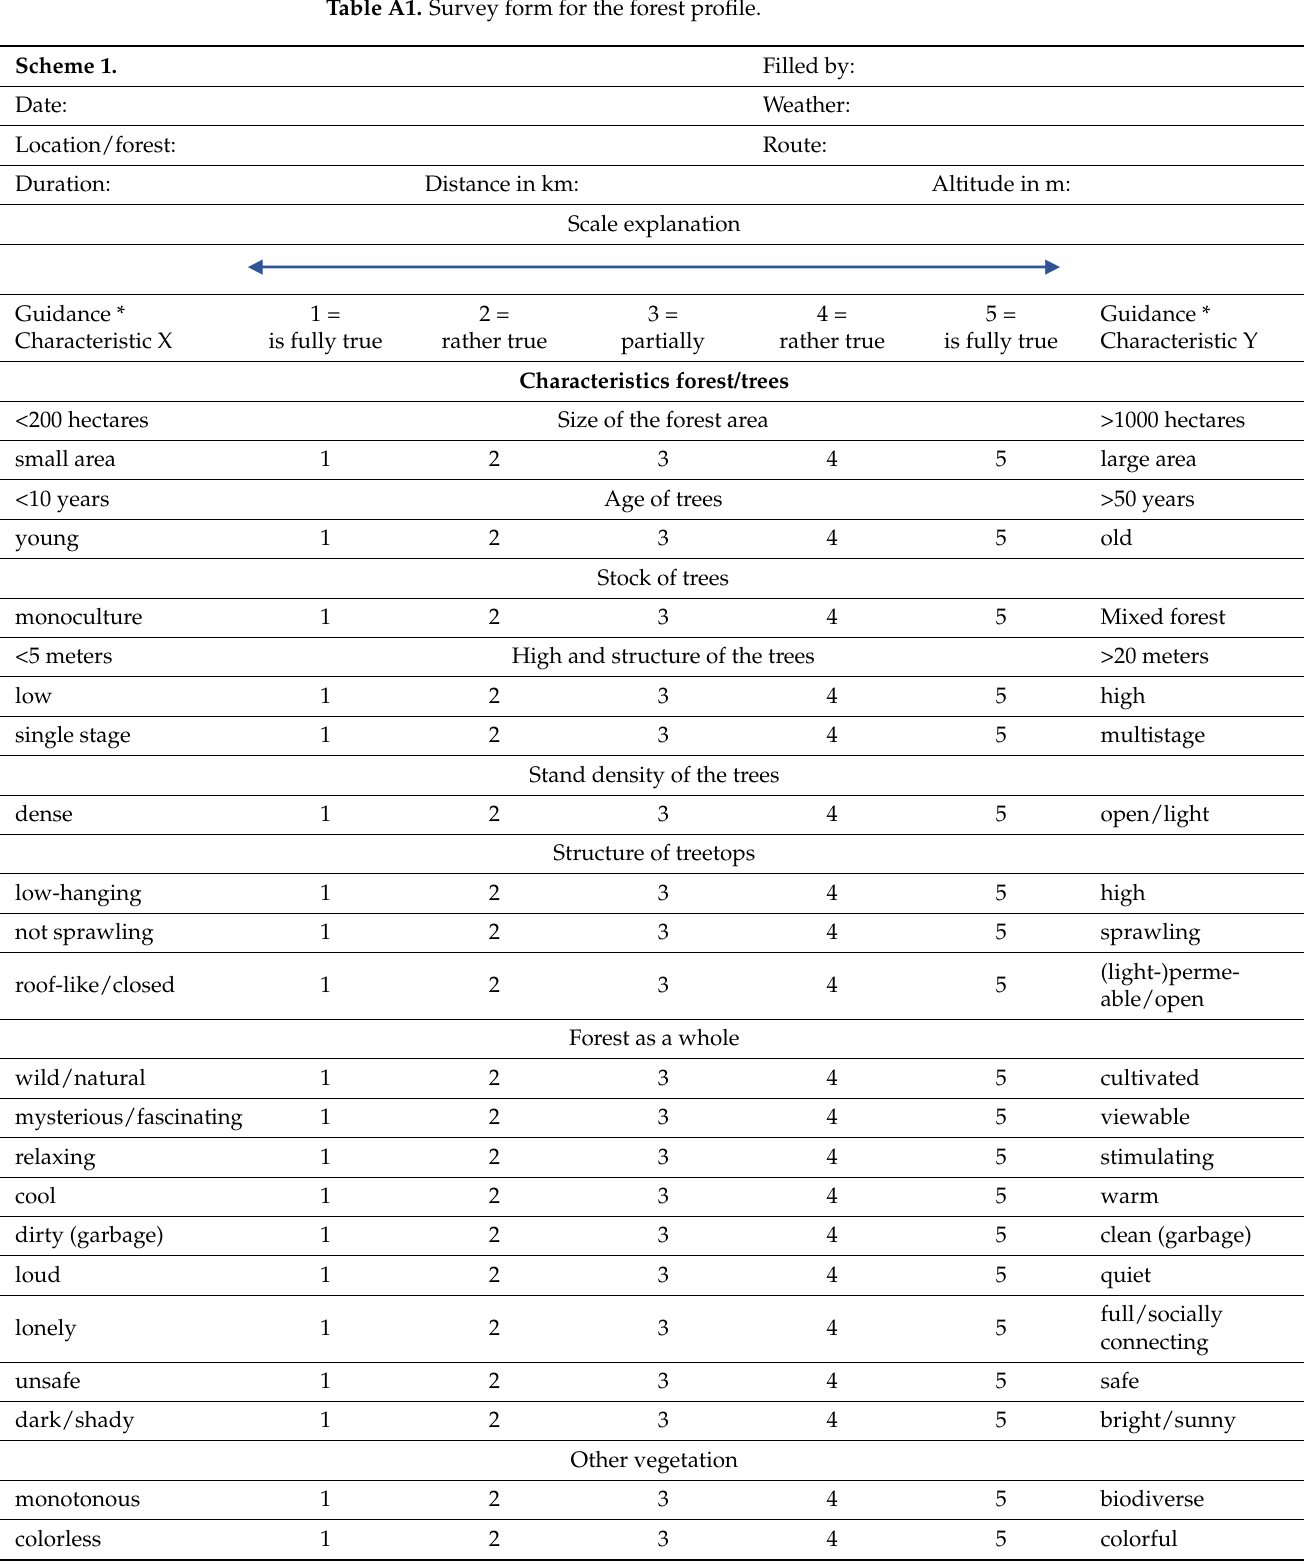
Table A1. Survey form for the forest